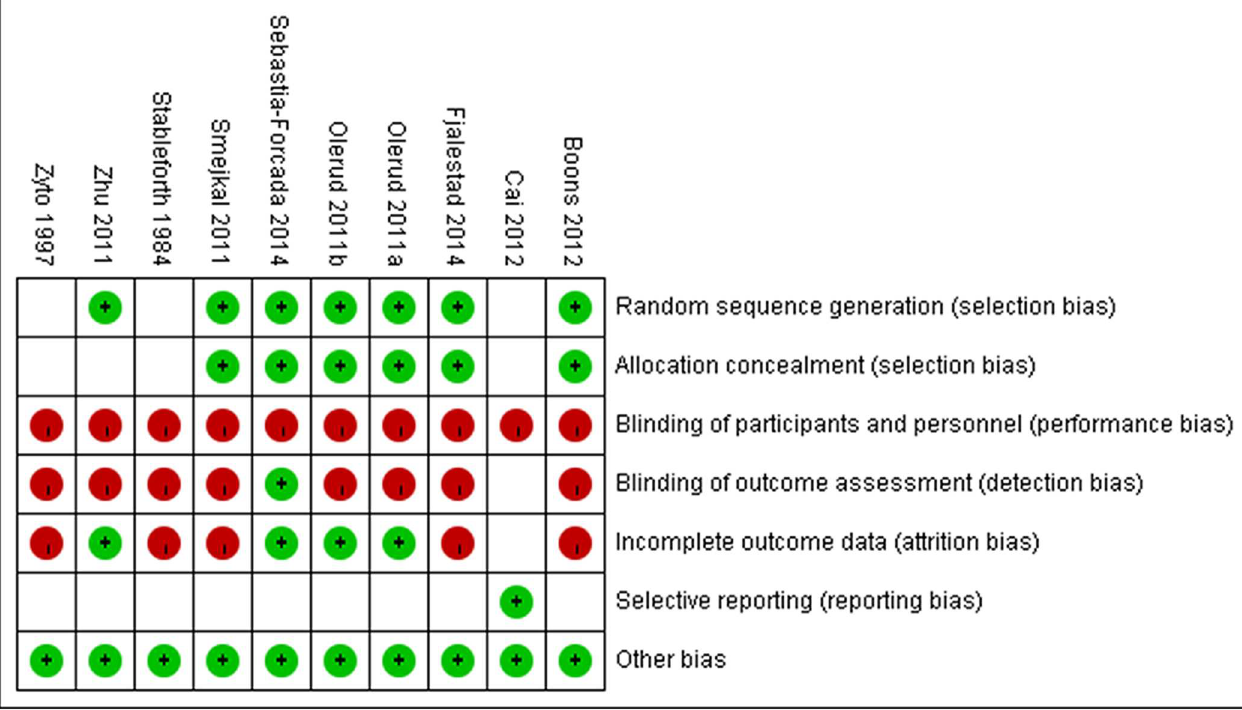
Fig 2. Risk of bias summary:review authors’ judgements about each risk of bias item for each included